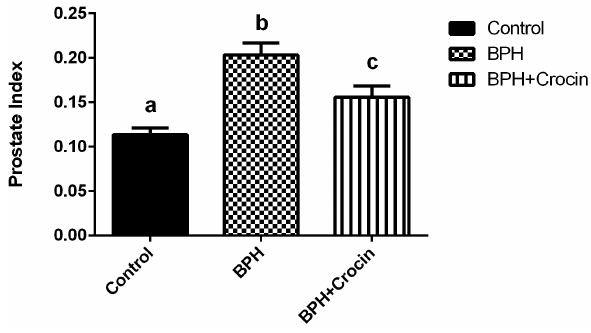
Fig. 1. Prostate index in the experimental rats showing the effect of crocin treatment. The results show the mean ± SEM. The significant difference was expressed as a different superscript letter in each group ( P < 0.05). Abbreviations: BPH, benign pro- static hyperplasia.